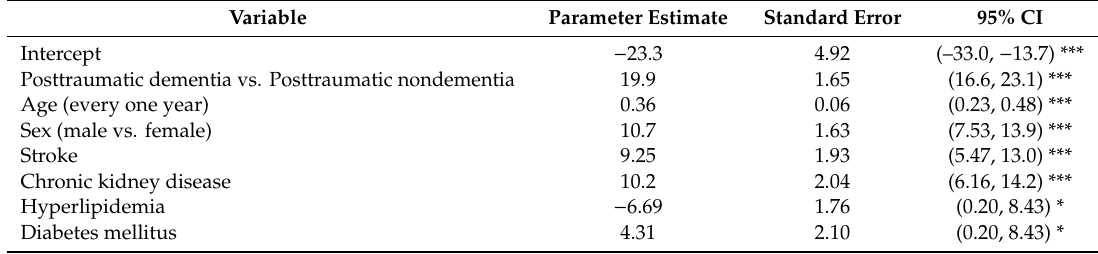
Table 4. Stepwise regression analysis for hospital days per year (all-cause